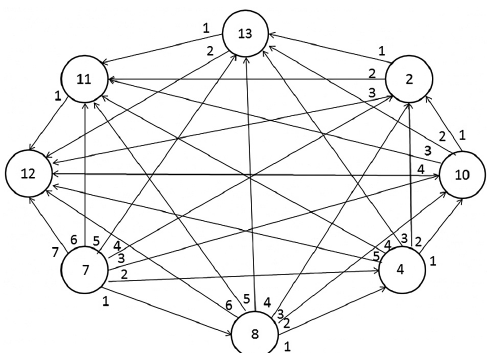
Fig. 4. The direction of the relationships and strength of the impact Source: compiled by